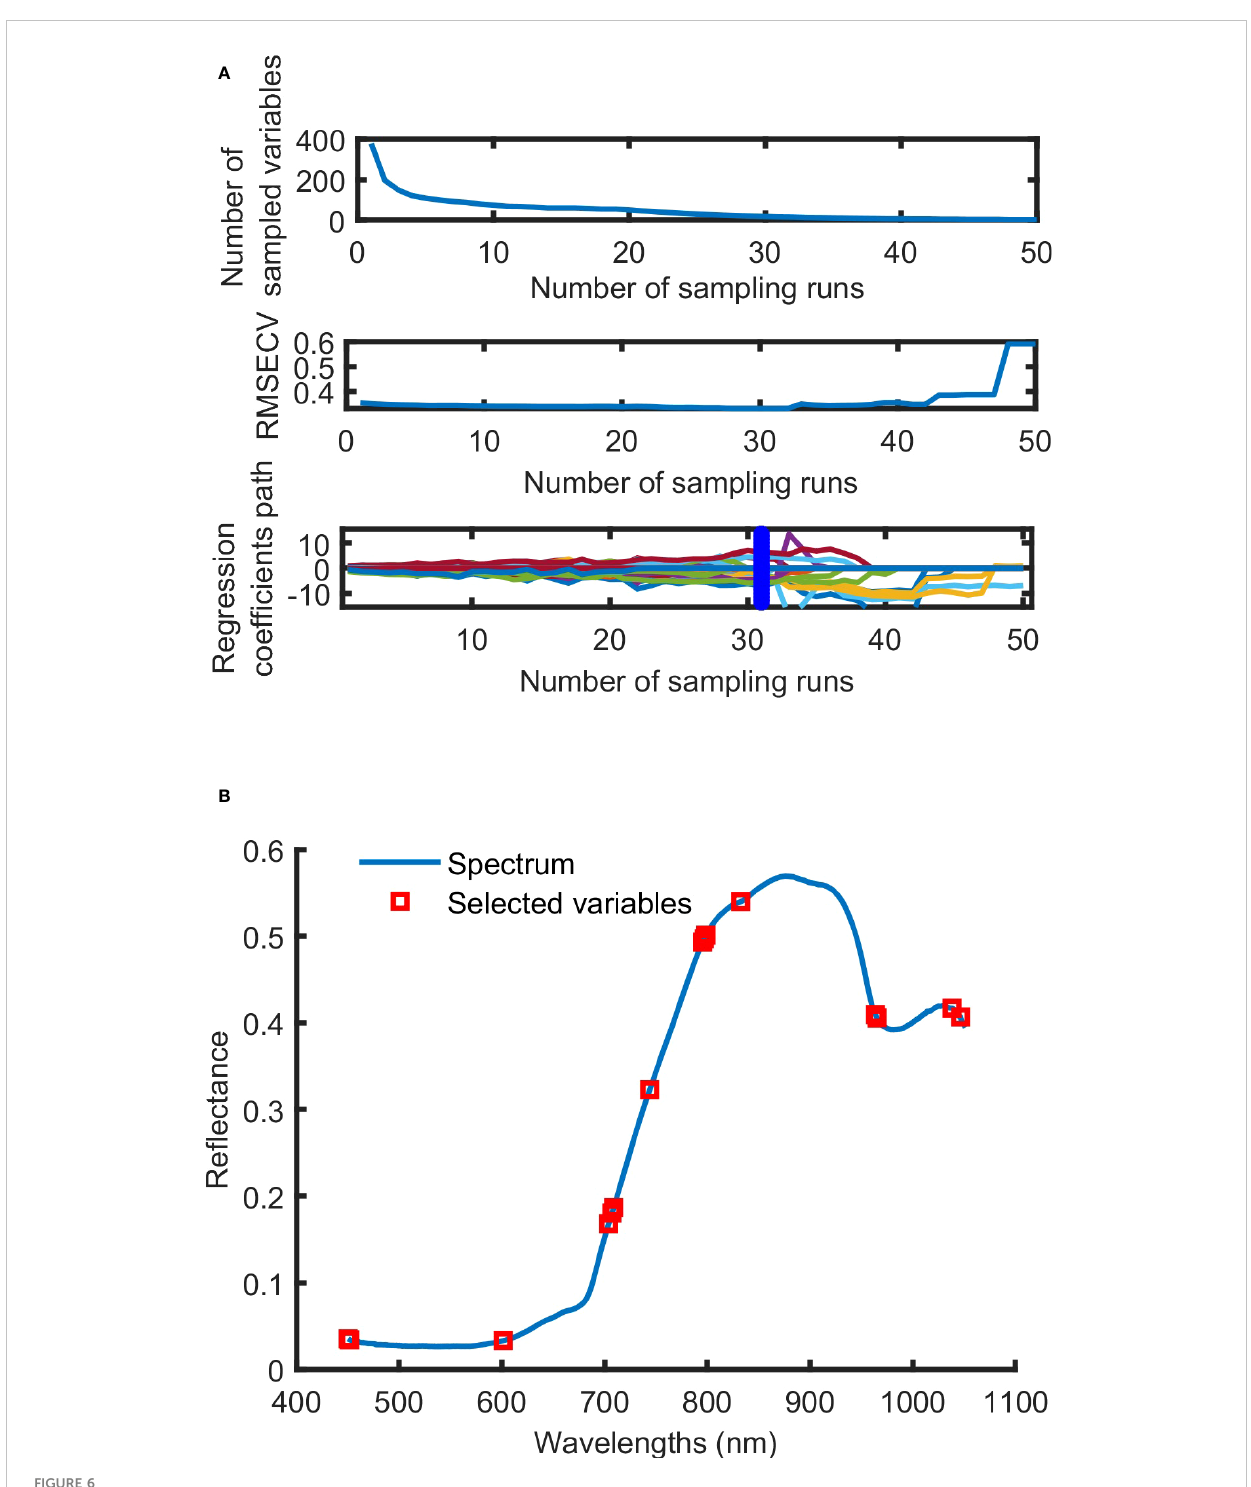
FIGURE 6 The process (A) and result (B) of characteristic wavelength selection by